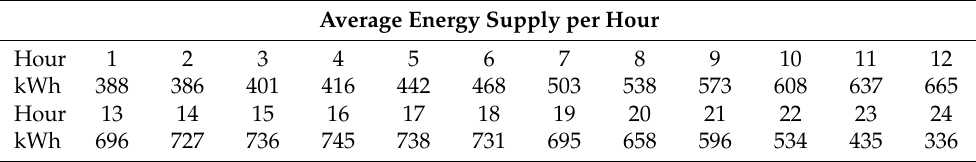
Table 3. Average total energy supply per hour per day from 5 chosen microgrids.